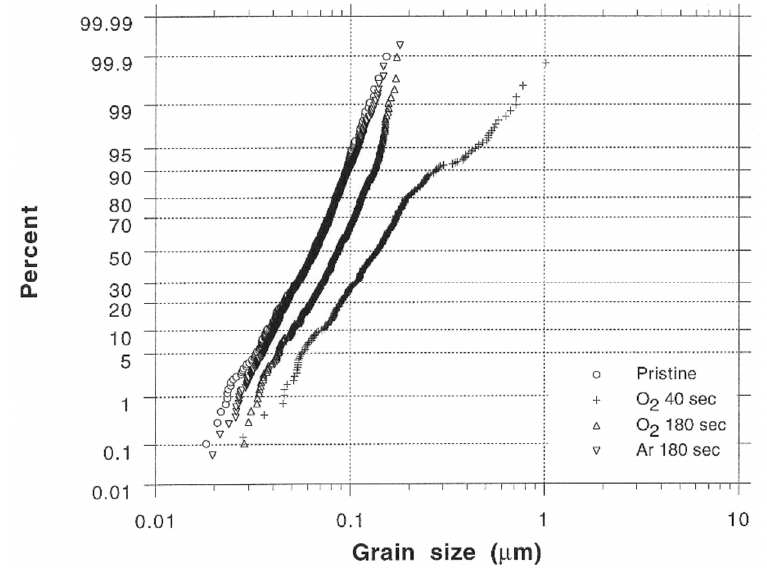
Figure 6. Log-normal plots of grain size distribution .